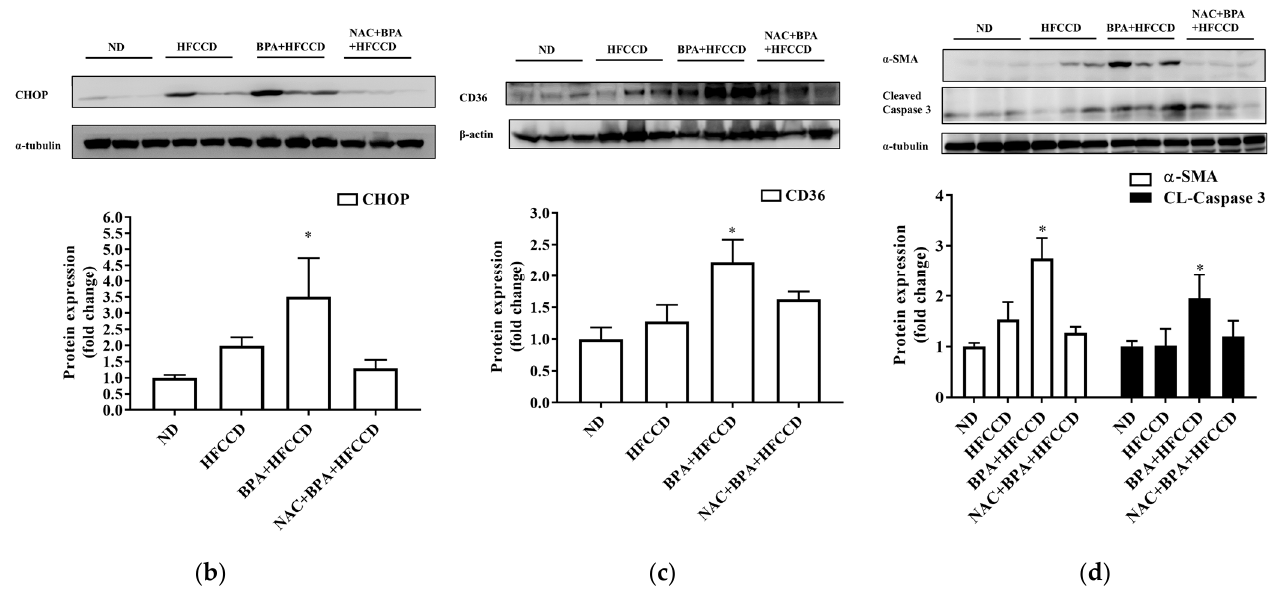
Figure 5. Regulation of ROS levels attenuated BPA-induced hepatic lipid accumulation and liver fibrosis. Eight-week-old C57BL/6 mice were administered an ND, HFCCD, BPA + HFCCD (50 µg/kg/day), or NAC (1 mg/mL, dissolved in drinking water) + BPA (50 µg/kg/day) + HFCCD for 8 weeks: ( a ) Images of liver tissues isolated from 8-week-old mice fed an ND, HFCCD, BPA + HFCCD, or NAC + BPA + HFCCD for 8 weeks, respectively. Sections of liver tissue were exposed to H&E staining, Masson’s trichrome staining (collagen fibers stained blue), Oil red O staining, and immunohistochemical staining (collagen 1). Scale bar: 200 µm. Protein expression of ( b ) CHOP, ( c ) CD36, and ( d ) α -SMA and cleaved caspase 3 (CL-Caspase3) in liver tissue was measured using western blot. Protein expression levels were normalized to α -tubulin. Data are shown as the mean ± SD of three independent experiments. * p < 0.05 vs. ND group.